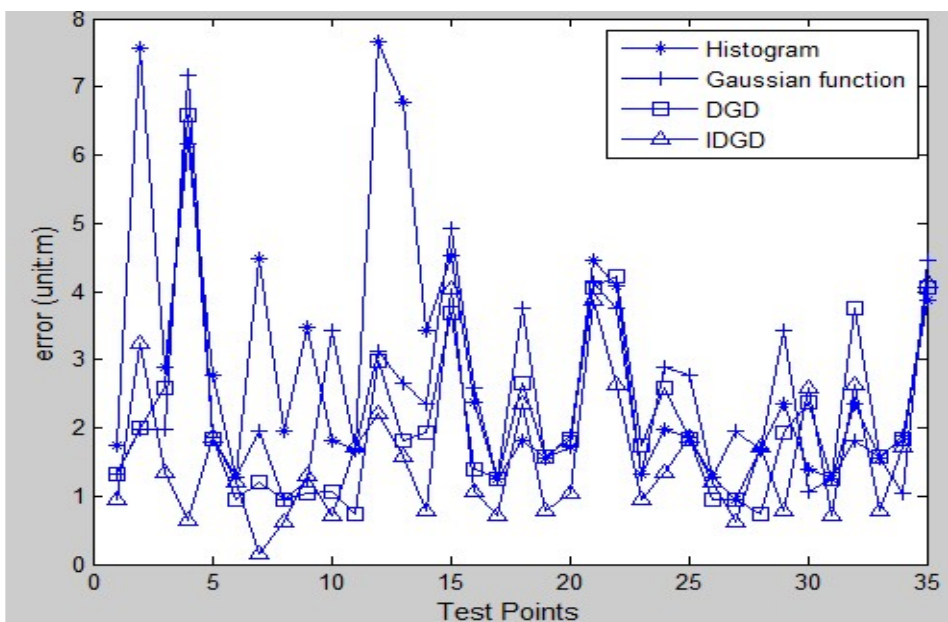
Figure 6. Errors at test points in test 2.